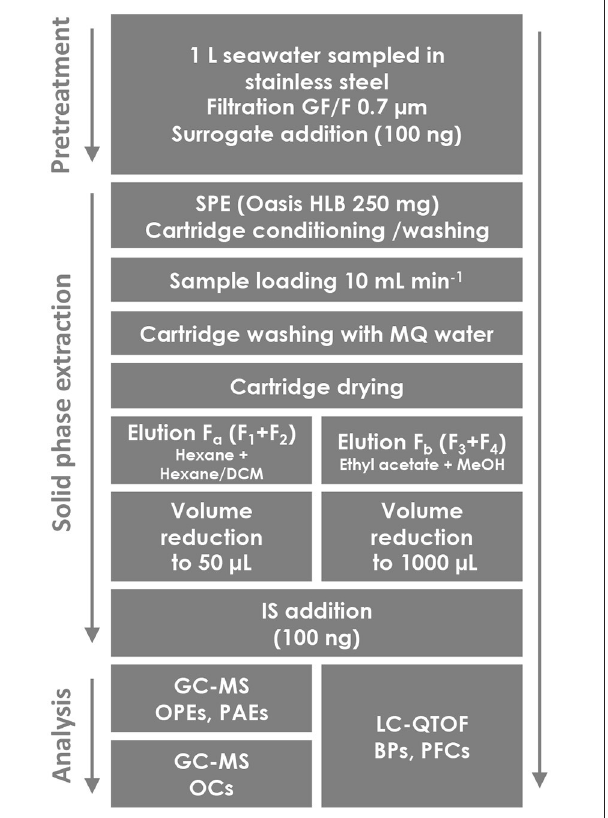
FIGURE 2 | Flowchart of the sampling and the SPE procedure of 40 contaminants extracted from